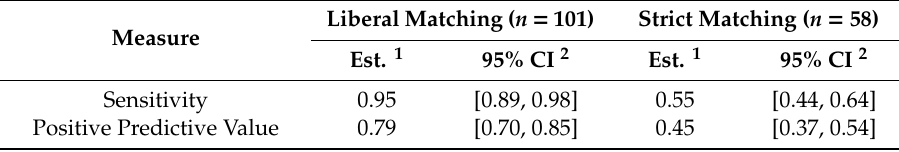
Table 2. Completeness of the administrative dataset by outlet matching strategy.